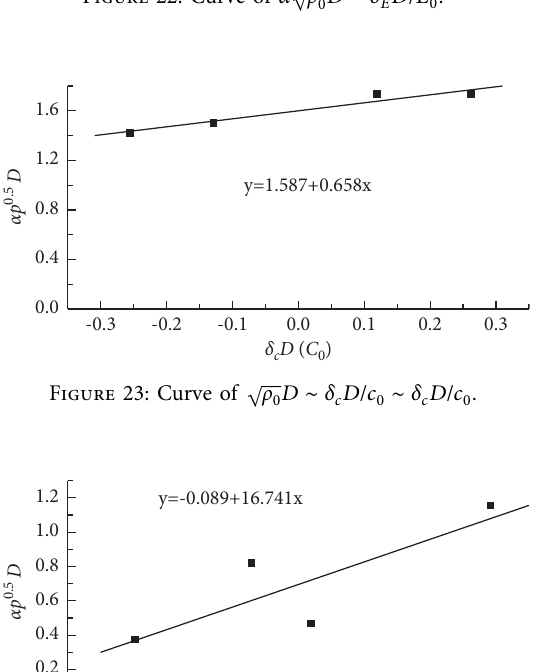
Figure 22: Curve of α �� ρ